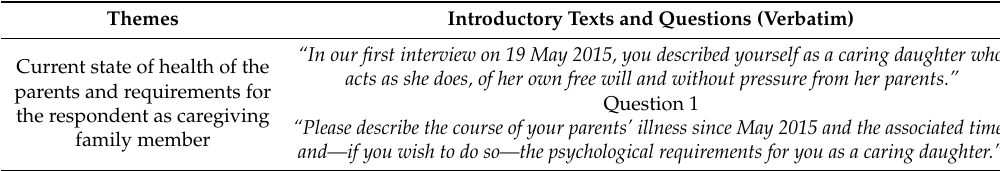
Table 2. Questionnaire for the second consultation in December